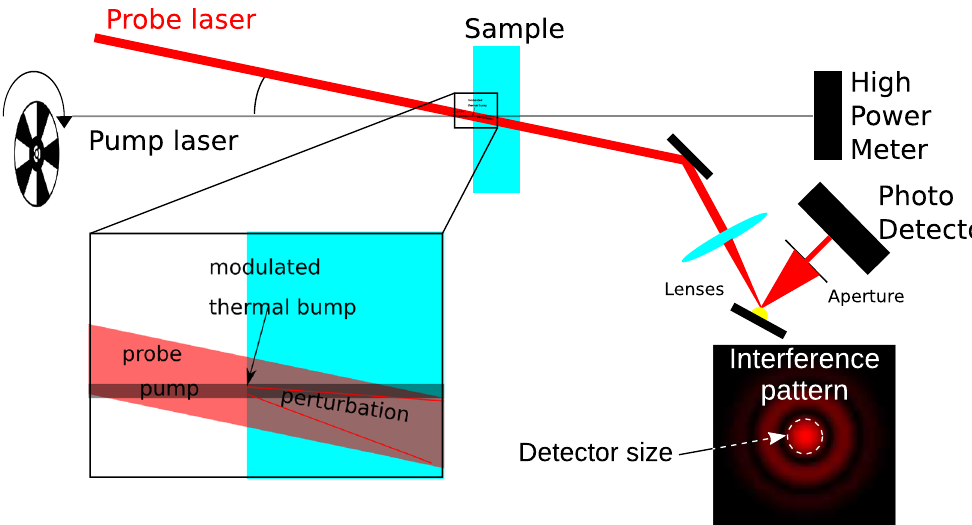
Figure 1. Concept diagram of the Photo-thermal Common-path Interferometer (PCI) method. The pump laser is a 20 W continuous-wave fiber-amplified diode laser at 1064 nm. The probe laser is a low-noise 5 mW Helium- Neon laser. The imaging unit (made by a converging lens) magnifies the interference pattern on the photo- detector. As the size of the photo-detector is smaller than the probe spot the intensity variation of the central part of the beam results in a periodic variation of the power detected by the